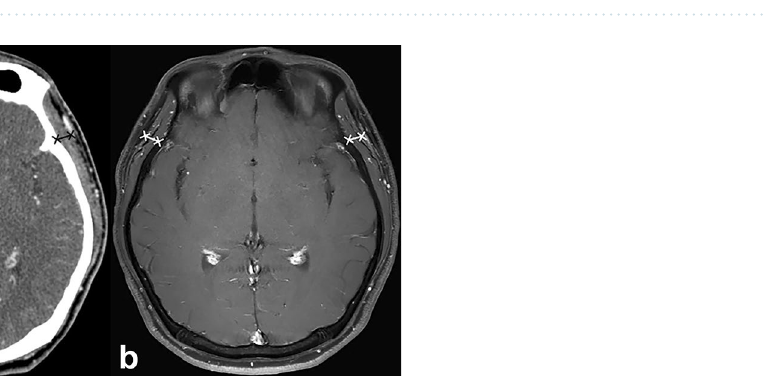
Figure 1. Flow diagram of the study population. HNSCC head and neck squamous cell carcinoma, CT computed tomography.